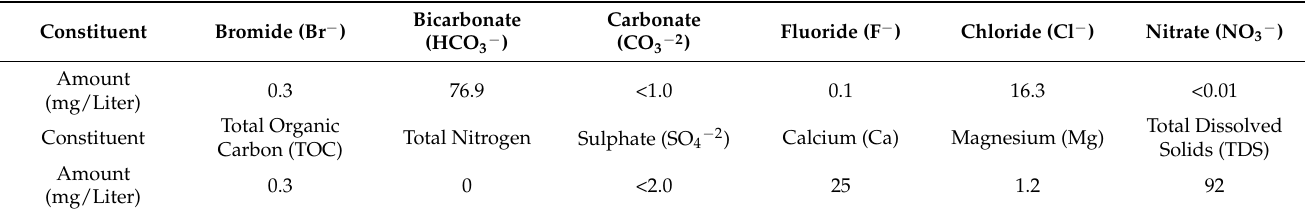
Table 2. Composition of tap water used in testing [40].